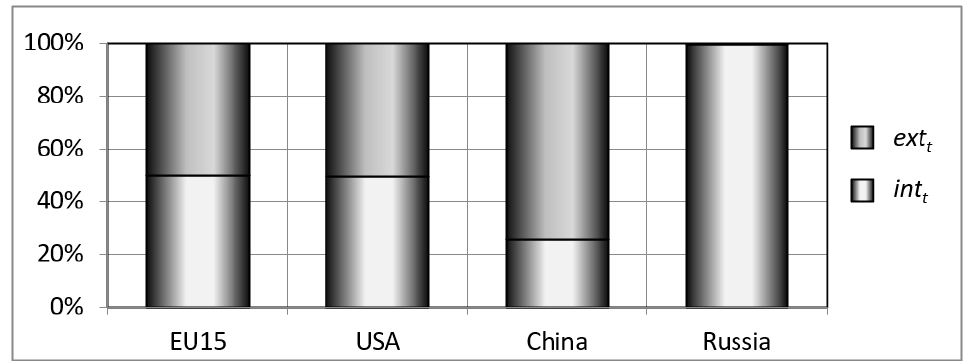
Figure 7. Averrage values of dynamic intensity and extensity indicators for the period 2011 – 2021.